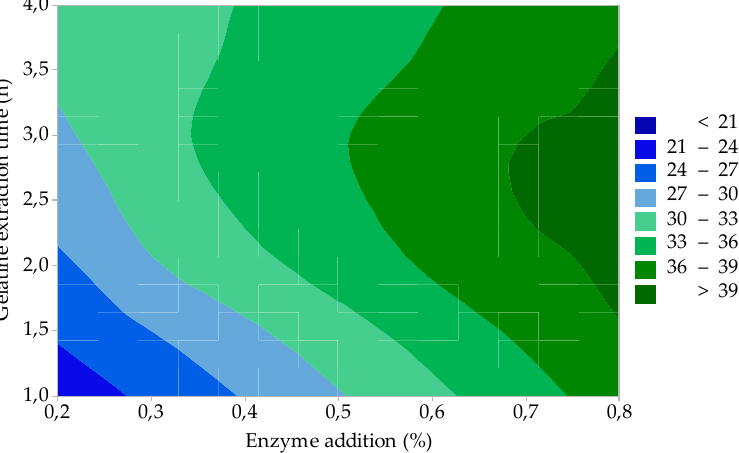
Figure 1. Effect of enzyme addition and gelatine extraction time on gelatine yield (study of the influence of process factors).